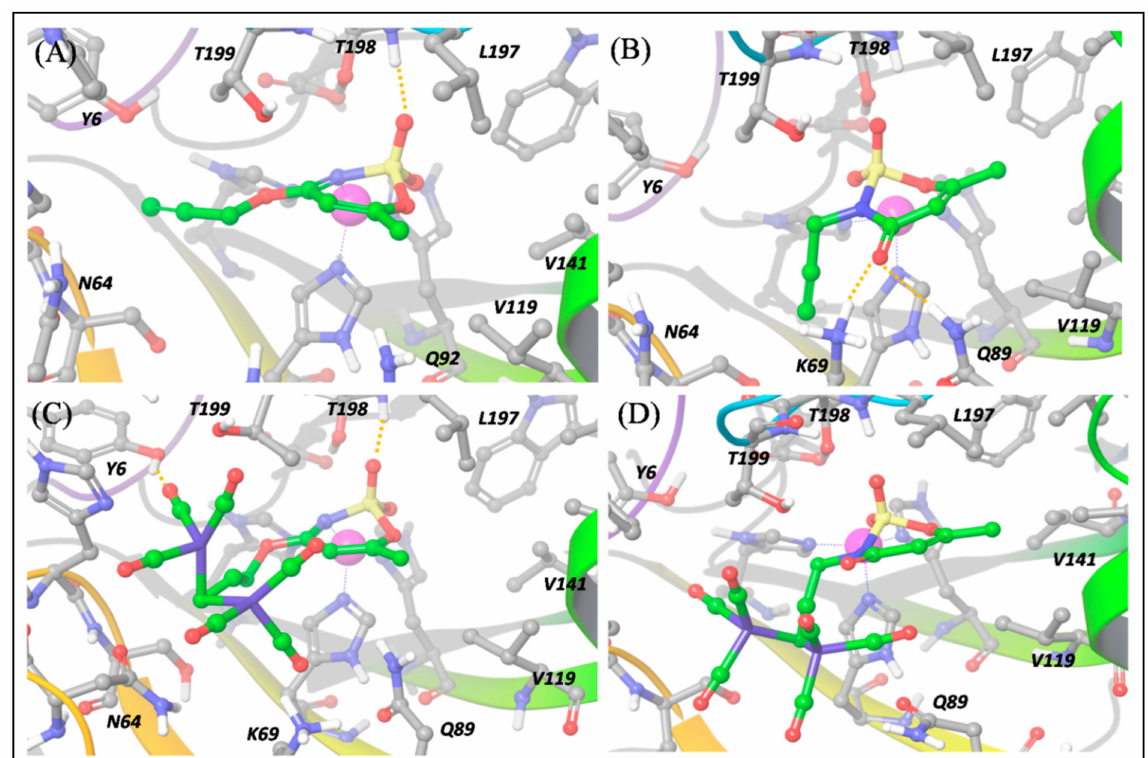
Figure 7. Predicted binding poses of a (panel ( A )), b (panel ( B )), 1 (panel ( C )) and 2 (panel ( D )) into hCA XII pocket. Hydrogen bond interactions are reported by orange dotted lines. The Zn 2+ ion is represented as a purple